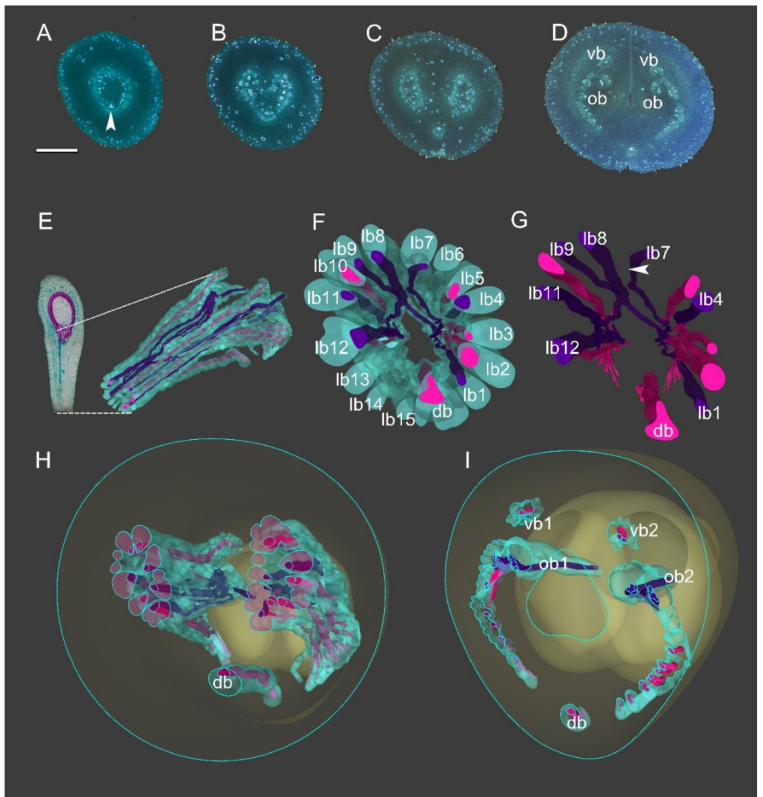
Figure 6. Three-dimensional construction of Anaxagorea javanica vasculature. Bundle outlines colored green, xylem red, and purple, among which bundles associated with ovule bundles are colored purple. ( A – D ) Aniline blue-stained A. Javanica sections, selected from the consecutive cross-sections for modeling. ( E ) Longitudinal section of mature A. Javanica carpel (left) and 3D vasculature model; dotted lines on longitudinal section indicate vasculature position in carpel. ( F ) Perspective from base of carpel vasculature. ( G ) Perspective from base of carpel (xylem only). The arrow indicates the intersection of two lateral bundles which fed two ovules, respectively. ( H ) Cross-section of 3D model corresponding to C , showing ring-arranged lateral bundle complexes. ( I ) 3D model section showing distribution of vascular bundles at base of ovary. Db, dorsal bundle; lb, lateral bundle; ob, ovule bundle; vb, ventral bundle. Scale bars = 500 µ